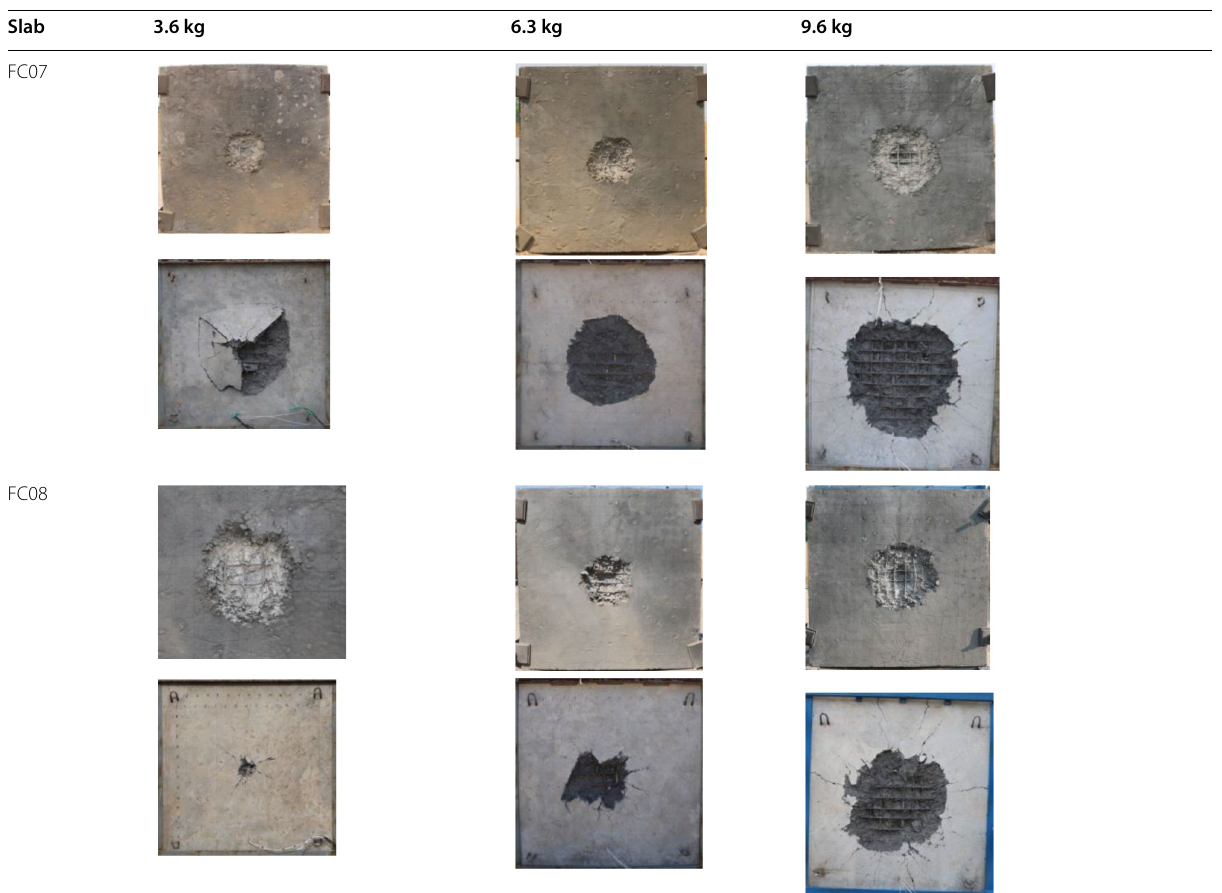
(4) Test results of length–diameter ratio